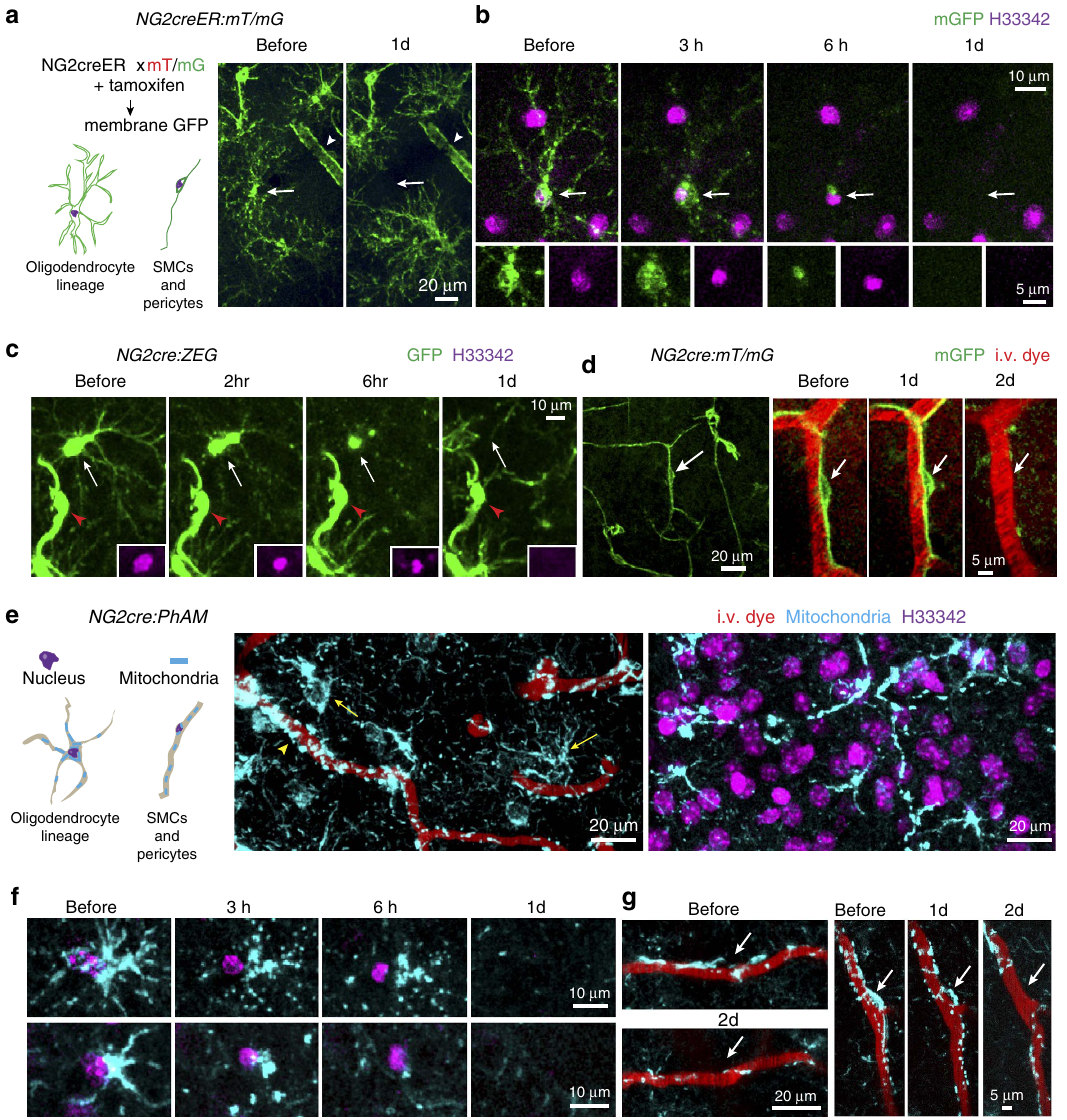
Figure 9 | 2Phatal of NG2 glia and vascular pericytes. ( a ) Schematic showing membrane anchored GFP targeted to oligodendrocyte lineage cells and vascular mural cells after tamoxifen administration and in vivo images showing ablation of a single NG2 glial cell (arrow) with a smooth muscle cell indicated (arrowhead). ( b , c ) In vivo time-lapse sequences showing nuclear pyknosis and formation of apoptotic bodies after photobleaching in single NG2 glia (arrows). Vascular mural cells are indicated (red arrowheads). ( d ) Ablation of a single vascular pericyte (arrow) at the time points indicated. ( e ) Schematic showing mitochondrial labelling in oligodendrocyte lineage cells and vascular mural cells in NG2 cre:PhAM transgenic mice. ( f ) In vivo time lapse sequence showing nuclear pyknosis and mitochondrial fission in single NG2 glia over 6h. ( g ) In vivo time-lapse images showing pericyte (arrows) mitochondrial fission and cell removal over 2 local production of ROS (CALI) 4,7,18,34 . Chromophores used in past studies range from exogenously applied dyes such as Malachite green 4 and Fluorescein 7 to genetically encoded fluorescent proteins such as EGFP 6 , KillerRed 8 , miniSOG 9,10